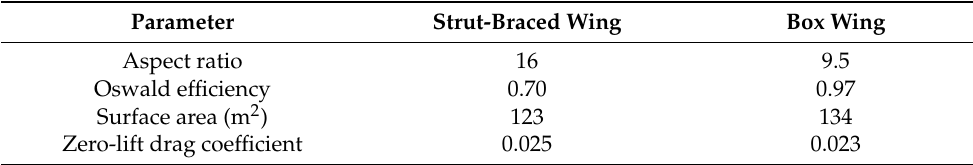
Table 7. Strut-braced wing (SBW) and box wing (BW) parameters compiled using data from [63]. Parameter